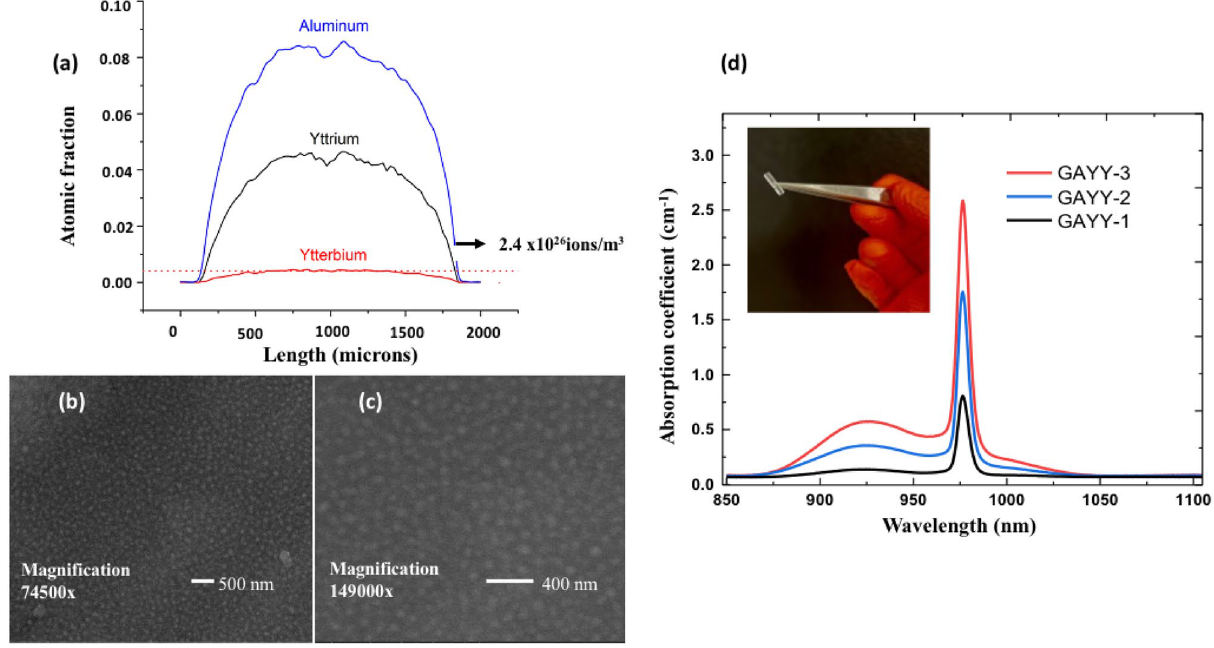
Figure 1. ( a ) EPMA analysis of GAYY-2, ( b , c ) SEM Image of phase separated preform (GAYY-2) at different magnifications, using backscattering electron mode ( d ) The absorption spectra of all GAYY glasses. The inset shows the highly transparent GAYY-2